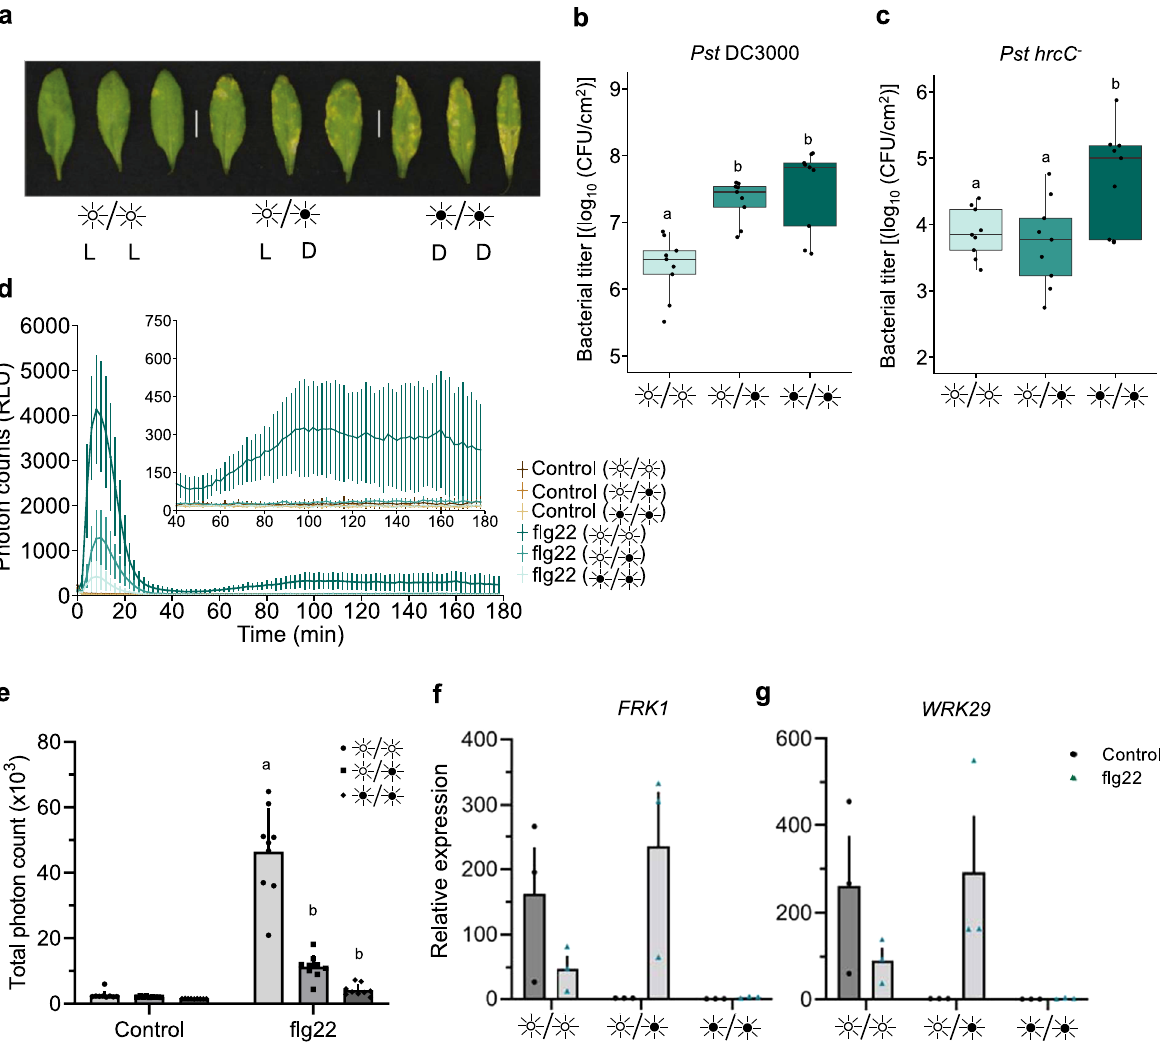
Fig. 1 | Constant light confers protection against Pst . a Disease phenotypes in Arabidopsis leaves syringe-in fi ltrated with Pst DC3000 (1×10 5 CFU/ml). WT Plants were either kept under constant light (LL), 12h light/dark (LD), or constant dark (DD) light cycles for 3 days after inoculation. Bacterial titers from WT leaves syringe-in fi ltratedwith Pst DC3000( b )or PsthrcC − ( c )at3dayspost-infection(dpi) under light regimes described in a ( n =3 biologically independent replicates). d Apoplastic oxidative burst triggered by 1 μ M fl g22 in WT Arabidopsis leaf pun- ches. Leaf punches were kept in water under LL, LD or DD for 24h prior to sti- mulation with fl g22. Values are averages ± se ( n =27). e Total photon counts measuredover180minfromtheexperimentsin d .ExpressionlevelsoftheearlyPTI